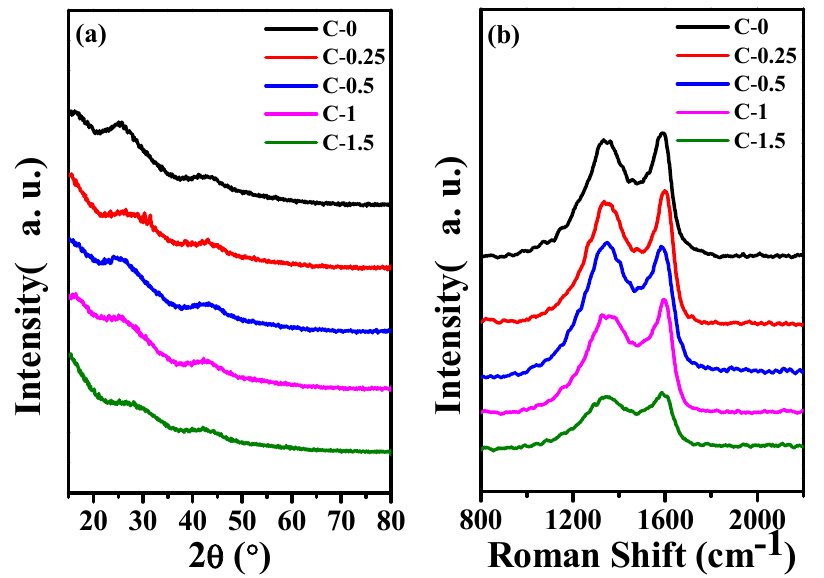
Figure 3. ( a ) The XRD curves of carbon fiber membrane based on potassium citrate/PAN C − 0, Figure 3. ( a )The XRD curves of carbon fiber membrane based on potassium citrate/PAN C − 0, C − 0.25, C − 0.25, C − 0.5, C − 1, C − 1.5 and ( b ) The Raman of C − 0, C − 0.25, C − 0.5, C − 1, C − C − 0.5, C − 1, C − 1.5 and ( b )The Raman of C − 0, C − 0.25, C − 0.5, C − 1, C − 1.5.